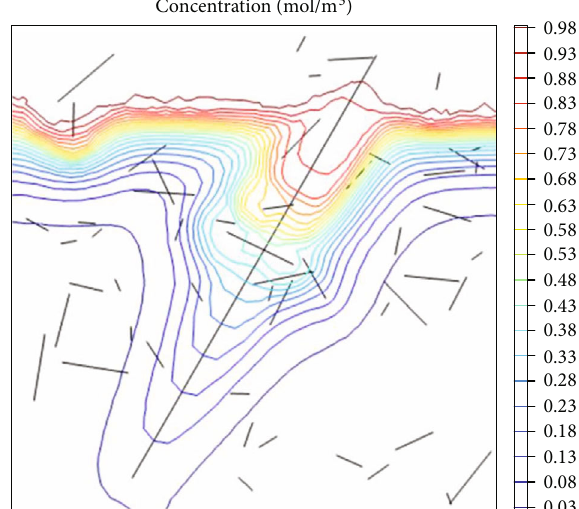
Figure 10: The concentration distribution contour of the MFF model.